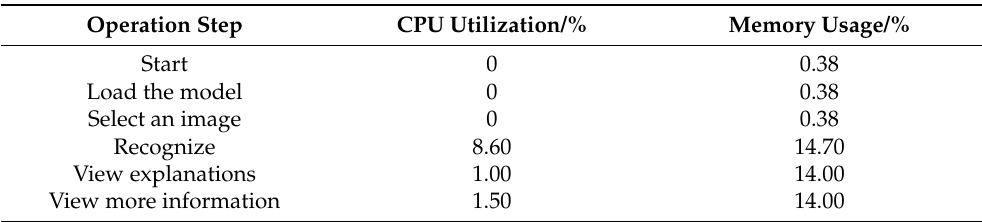
Table 5. CPU and memory utilization at each stage of system